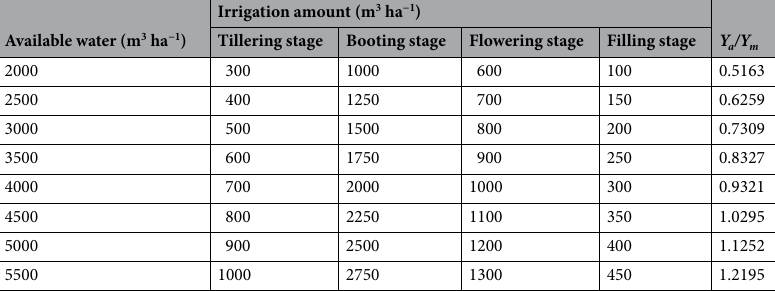
Table 9. Irrigation system optimization of rice under drip